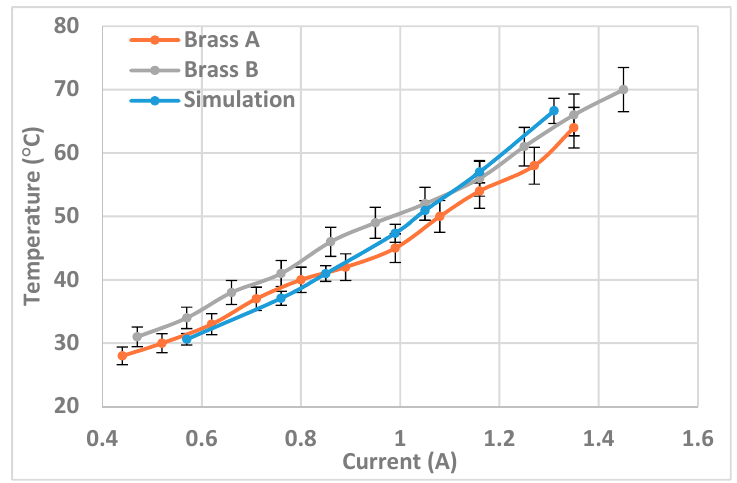
Figure 13. Brass foil temperature readings of two 150- µ m-tall brass actuators compared to simulation results.